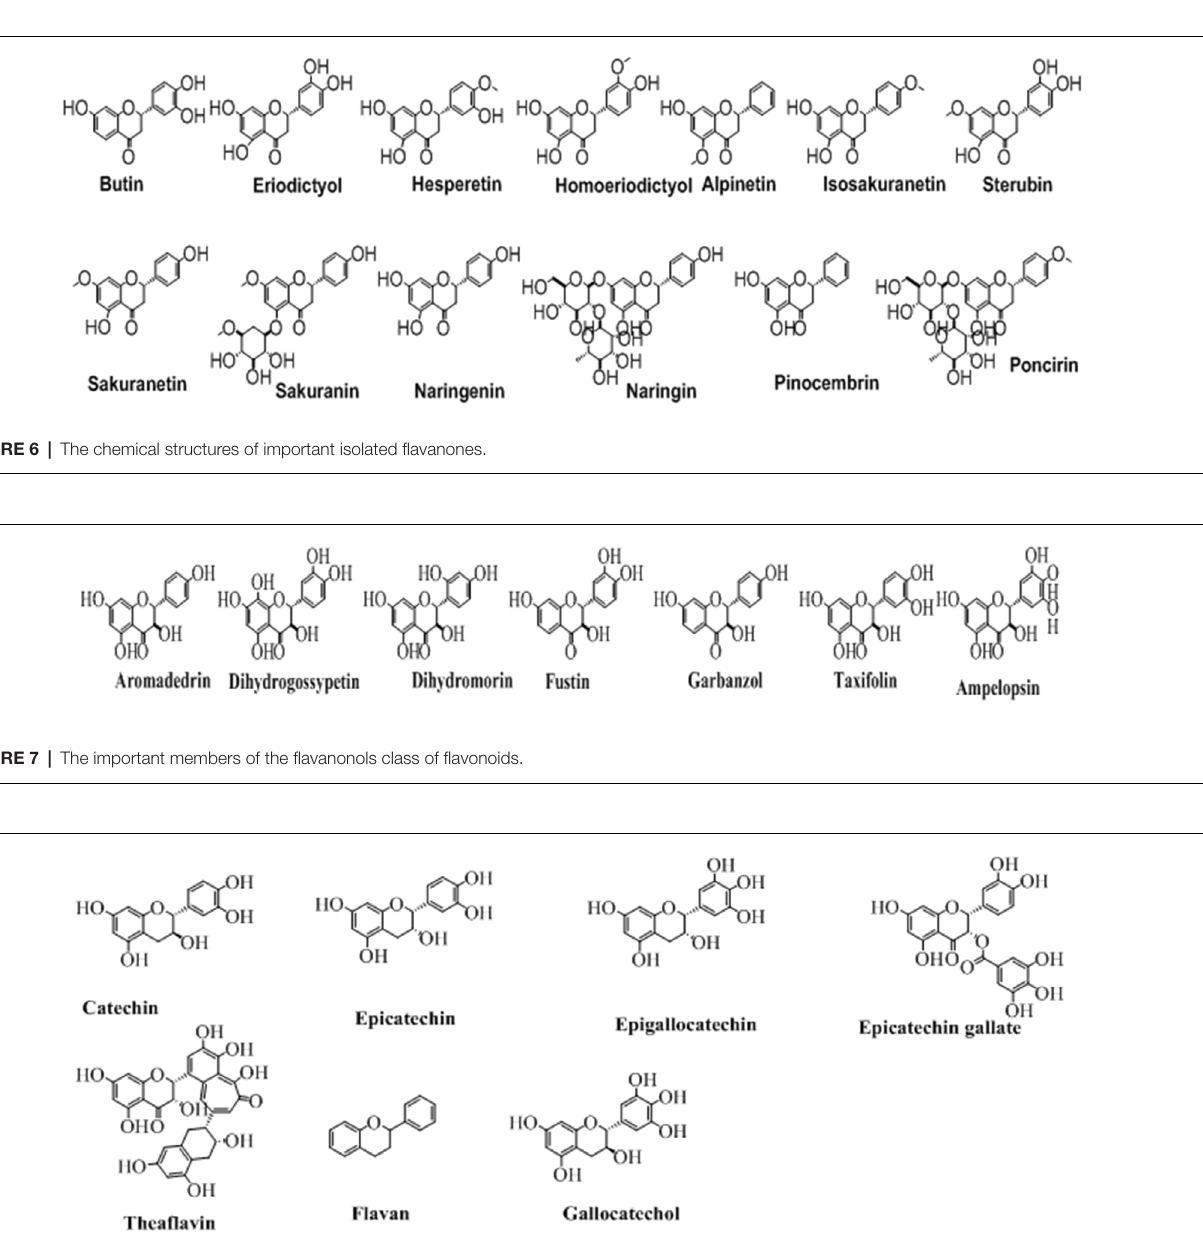
FIGURE 8 | The major flavanols derived from natural